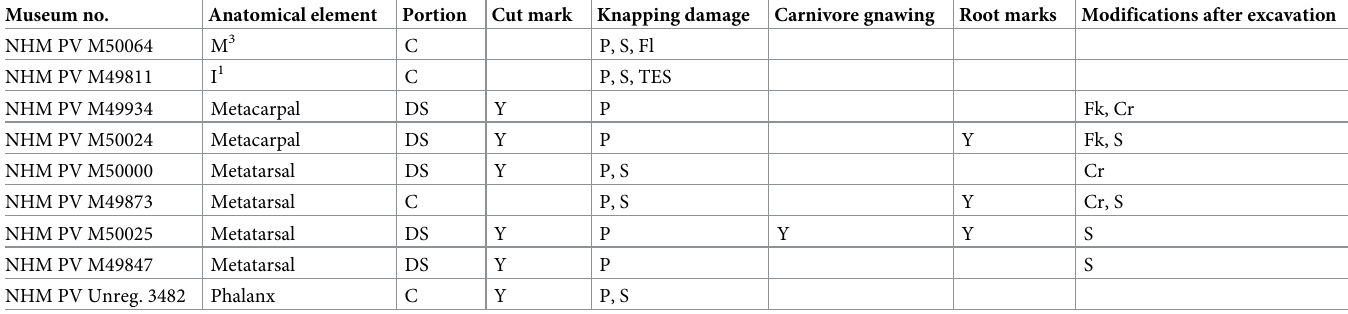
Table 3. Gough’s Cave knapping tools. Summary of taphonomic alterations. Museum